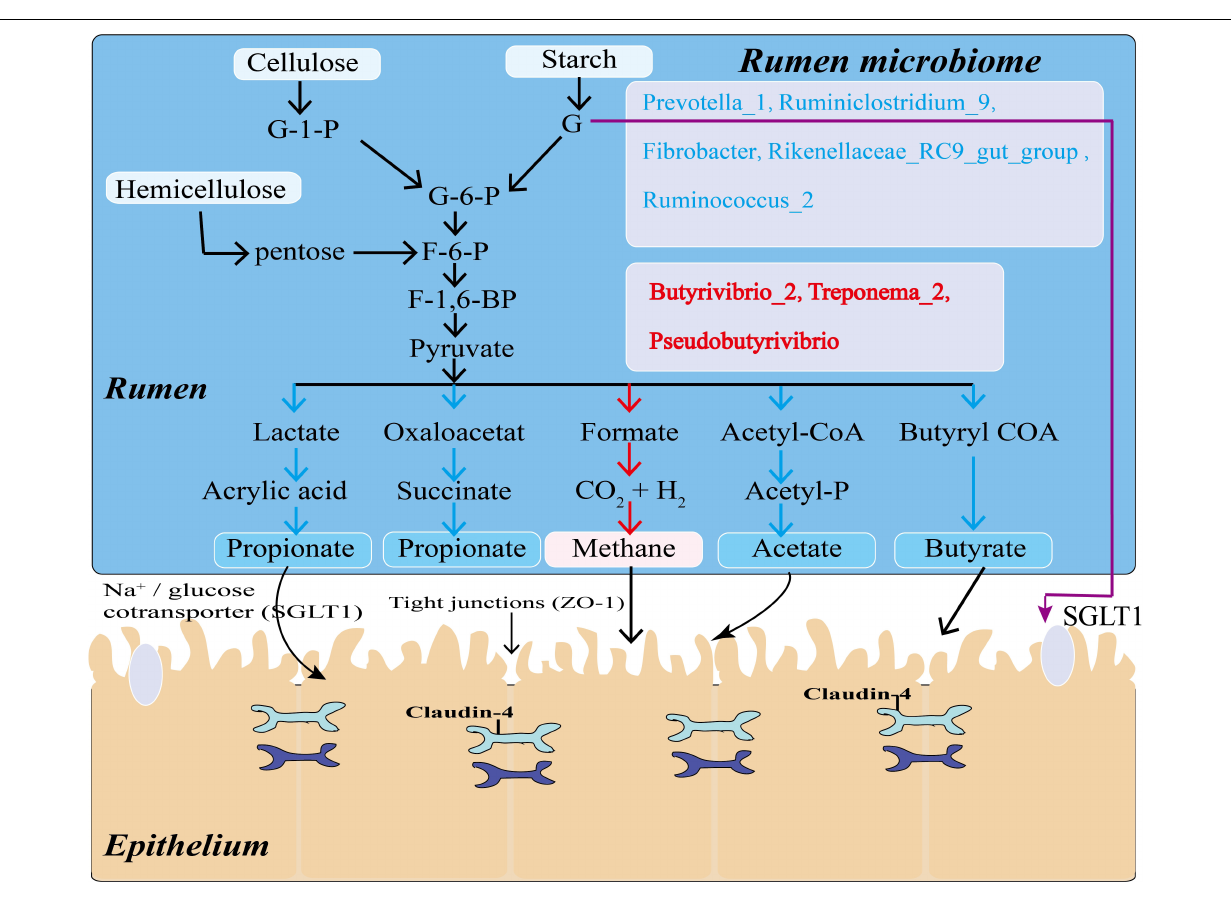
Frontiers in Microbiology |